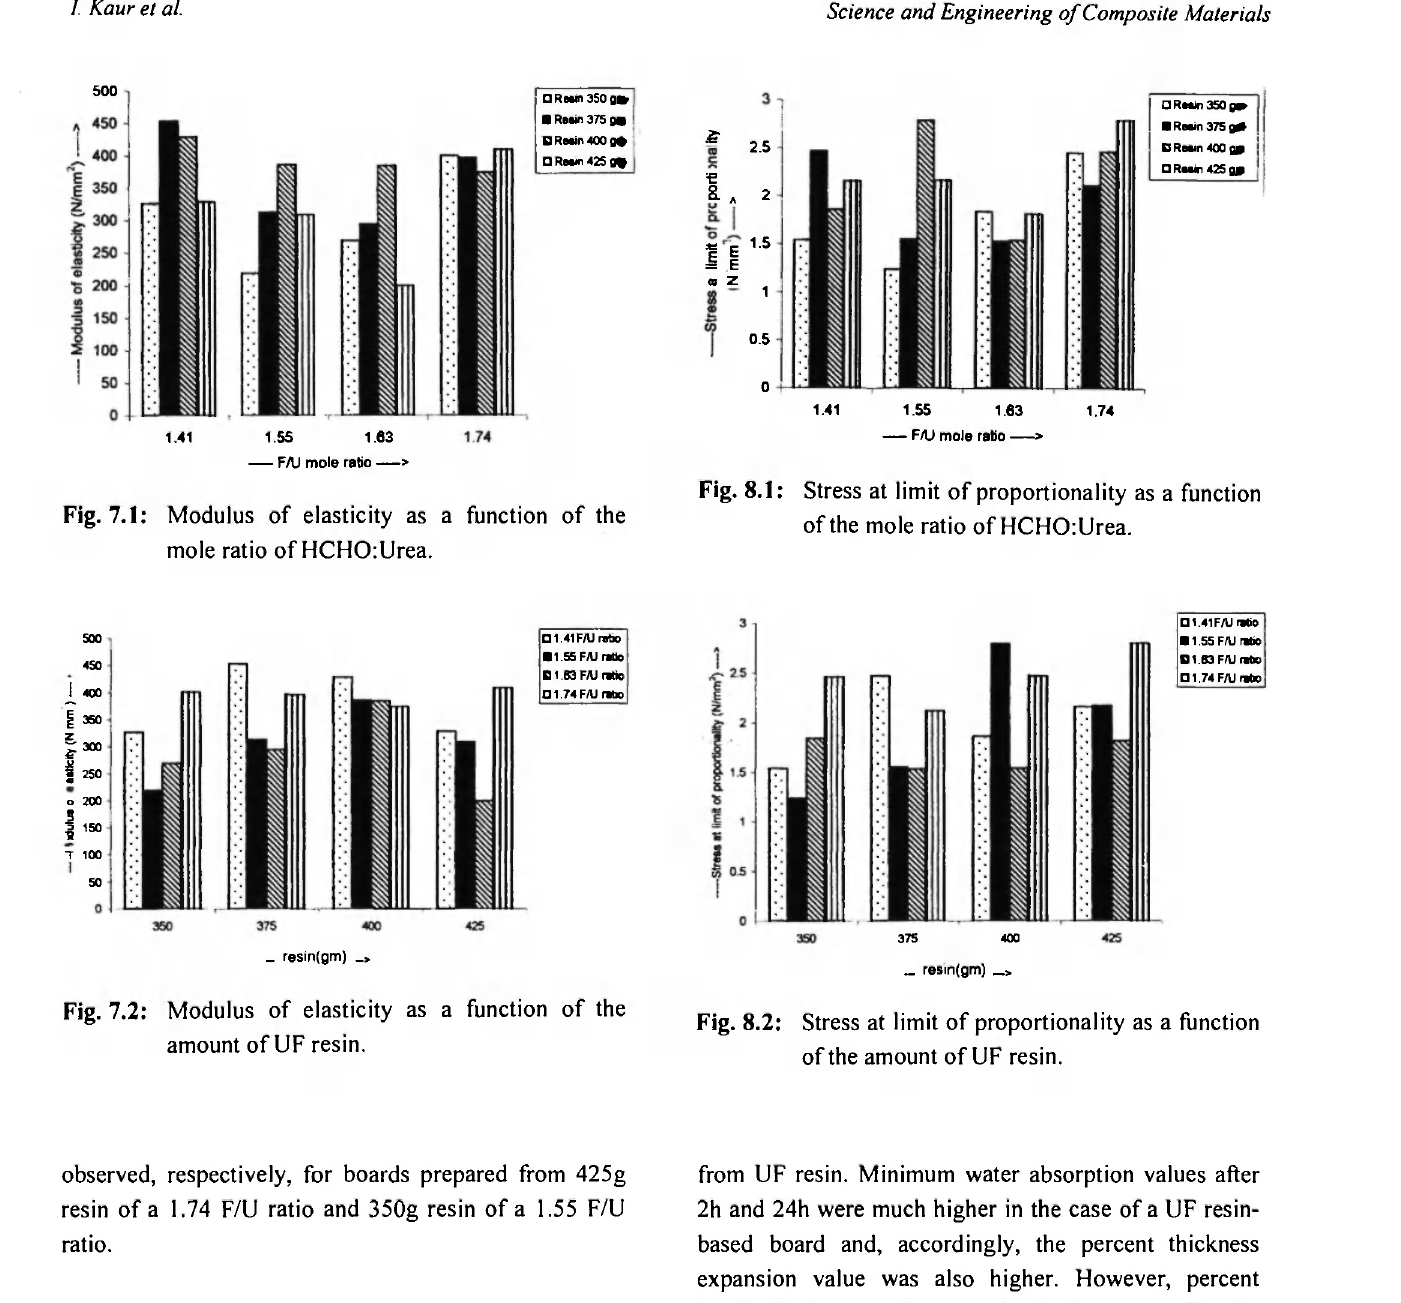
Fig. 7.2: Modulus of elasticity as a function of the amount of UF